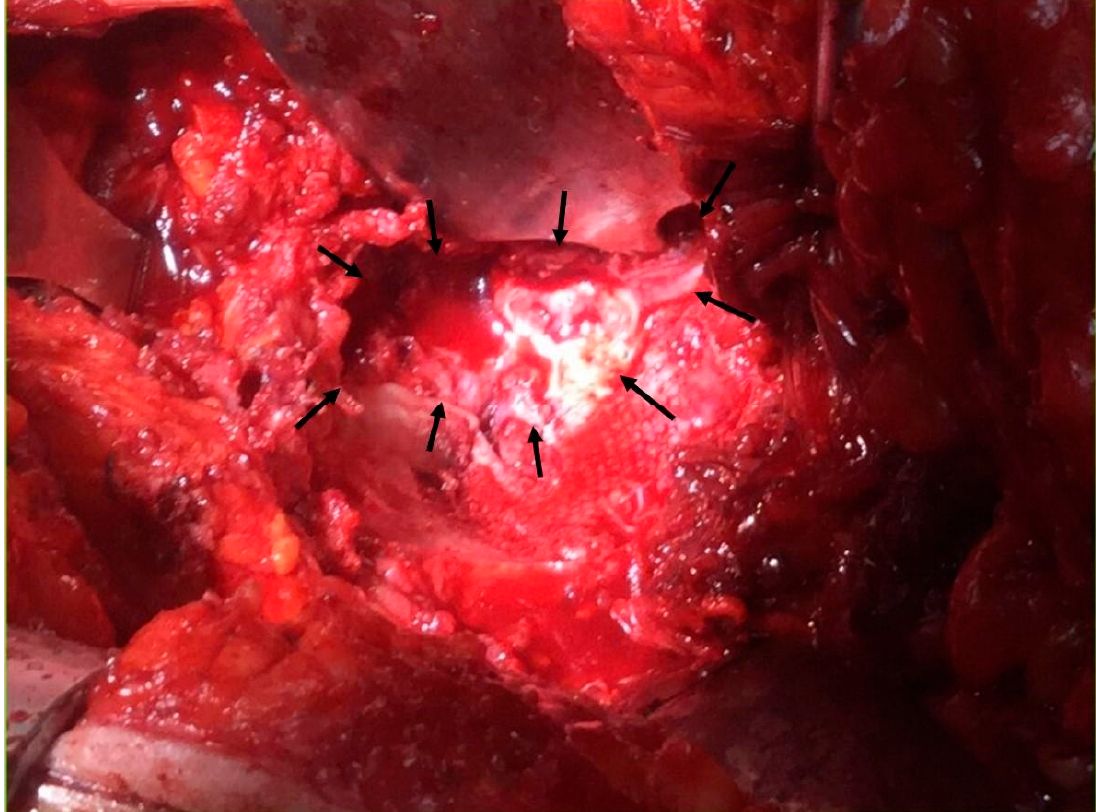
Figure 3. Intraoperative view of the massive acetabular bone loss (black arrows).